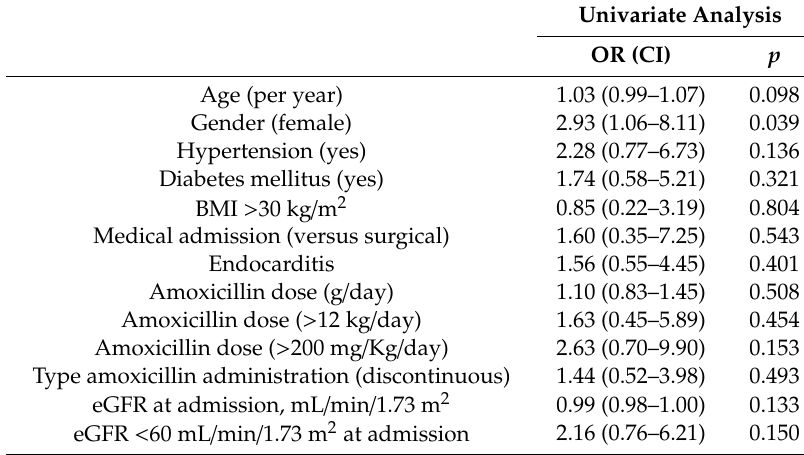
Table 5. Univariate analysis for risk factors associated with AICN. Patients with non AICN AKI as well as patient with Kidney Disease:Improving Global Outcome (KDIGO) stage I AKI were